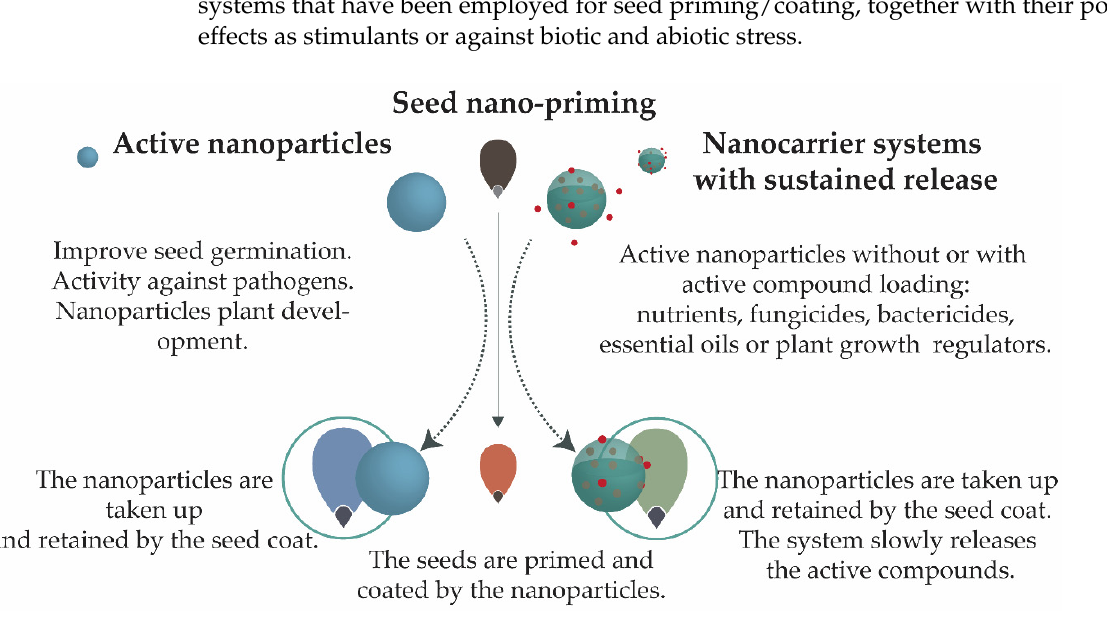
Figure 3. Seed nano-priming. The nanoparticles can be defined as (i) active nanoparticles, which are systems that can have a stimulatory effect on plant growth and development, or (ii) nanocarrier systems providing sustained release, where the nanoparticles can be active or inactive, and are loaded with an active ingredient. Table 1. Nanoparticles employed for seed priming and coating, showing the nanoparticle systems, their characteristics, and the main effects on the species evaluated. Each article is classified according its application: A1 (seed priming), A2 (effects in the field), A3 (effects against pathogens), and A4 (relieving abiotic stresses). The arrows up and down indicated an increase and decrease in activity, respectively.